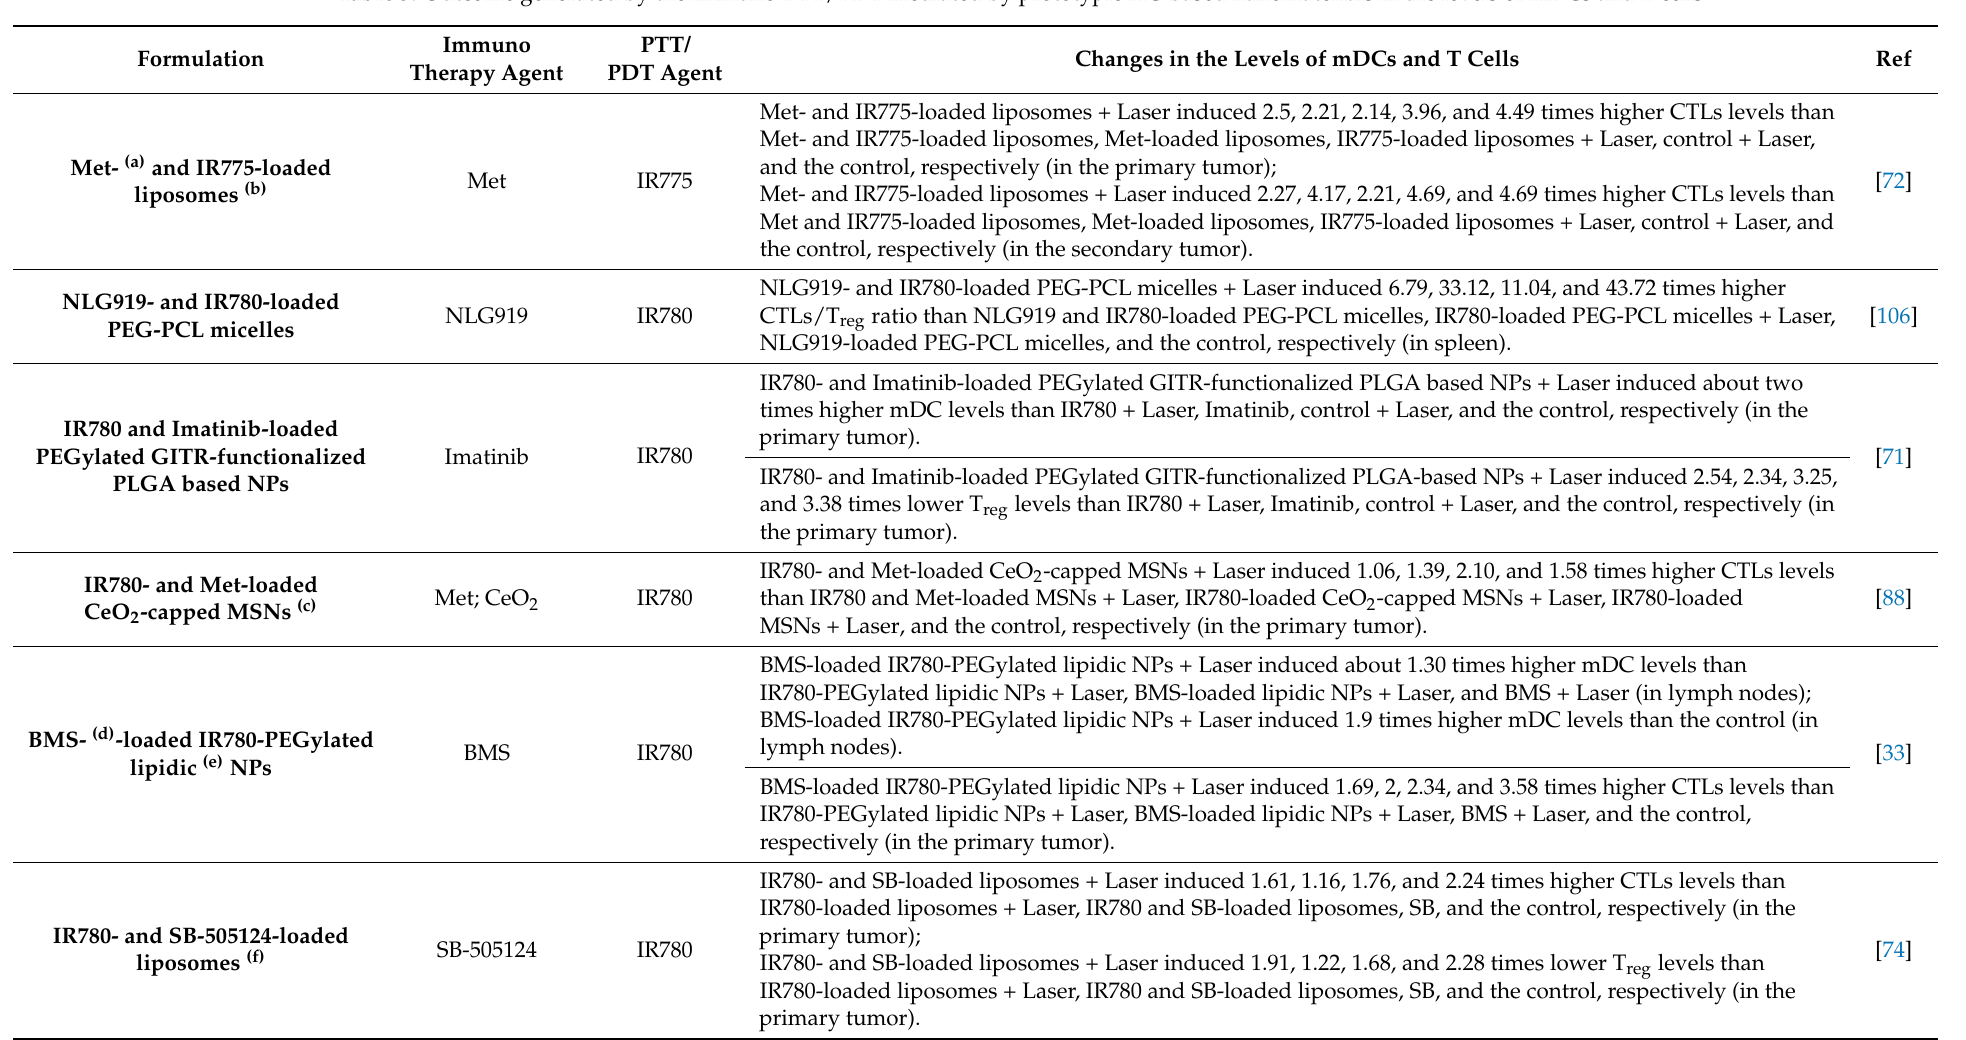
Table 3. Outcome generated by the immuno-PTT/PDT mediated by prototypic HC-based nanomaterials in the levels of mDCs and T